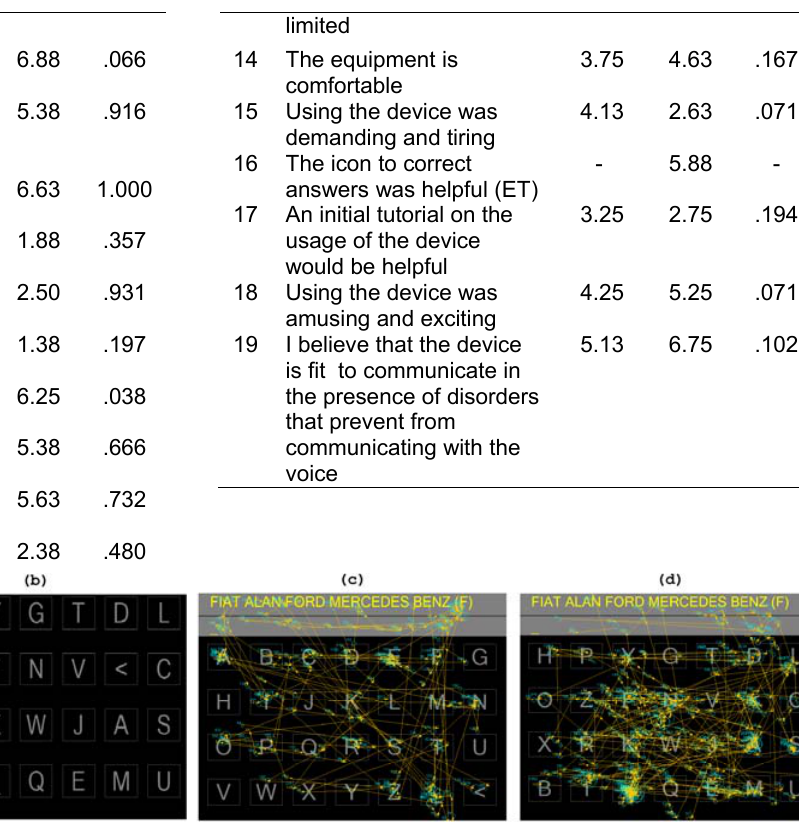
Figure 3 . The used ET Keyboards and the Saccades plotted over them: (a) Standard Virtual Keyboard, (b) Scrambled Keyboard, (c) Saccades on Standard Virtual Keyboard, (d) Saccades on Scrambled